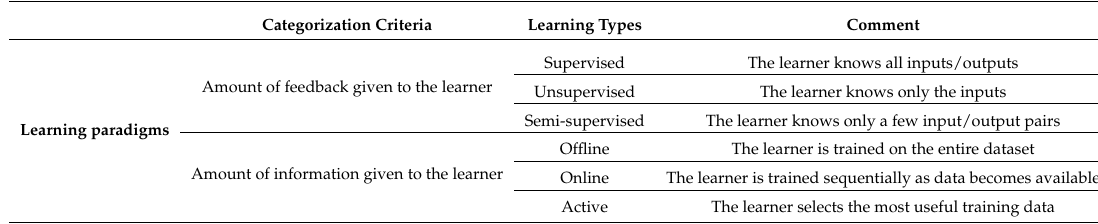
Table 1. Summary of types of learning